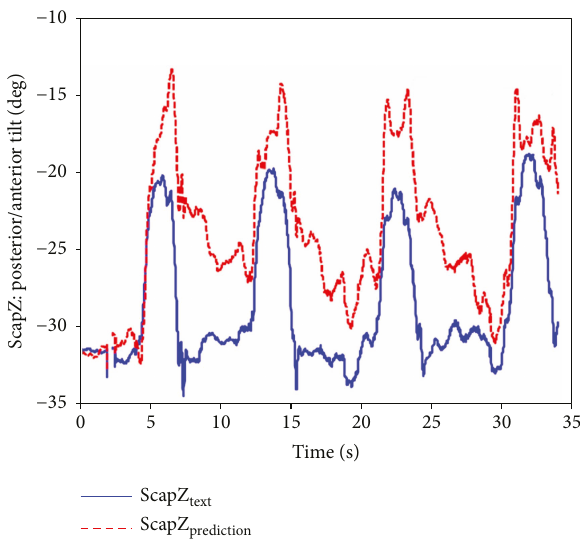
Figure 17: Comparison of anterior tilt obtained by prediction and measurement.